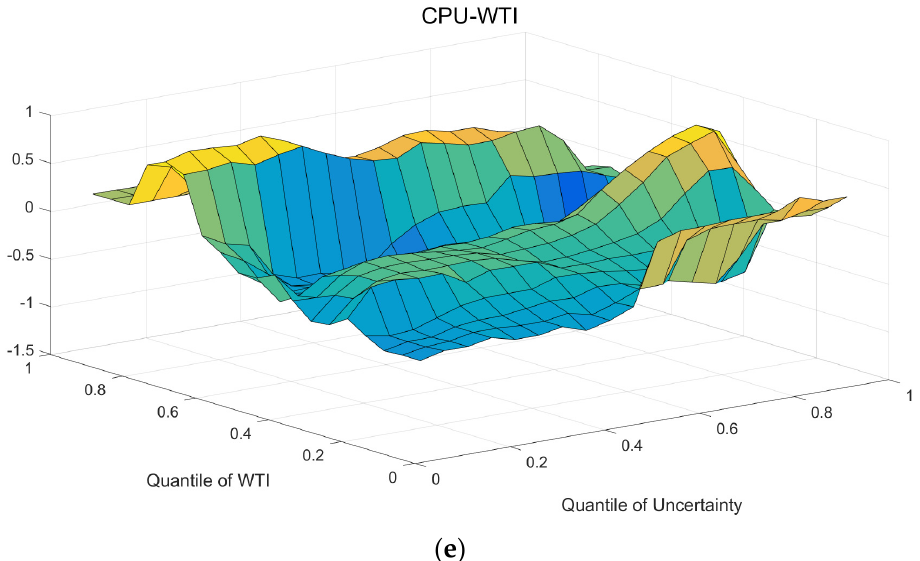
Figure 5. Estimation of the impact coefficients of the CPU on the WTI at different time scales. ( a ) The impact of the CPU on the WTI at D1; ( b ) The impact of the CPU on the WTI at D2; ( c ) The impact of the CPU on the WTI at D3; ( d ) The impact of the CPU on the WTI at D4; ( e ) The impact of the CPU on the WTI at D5.